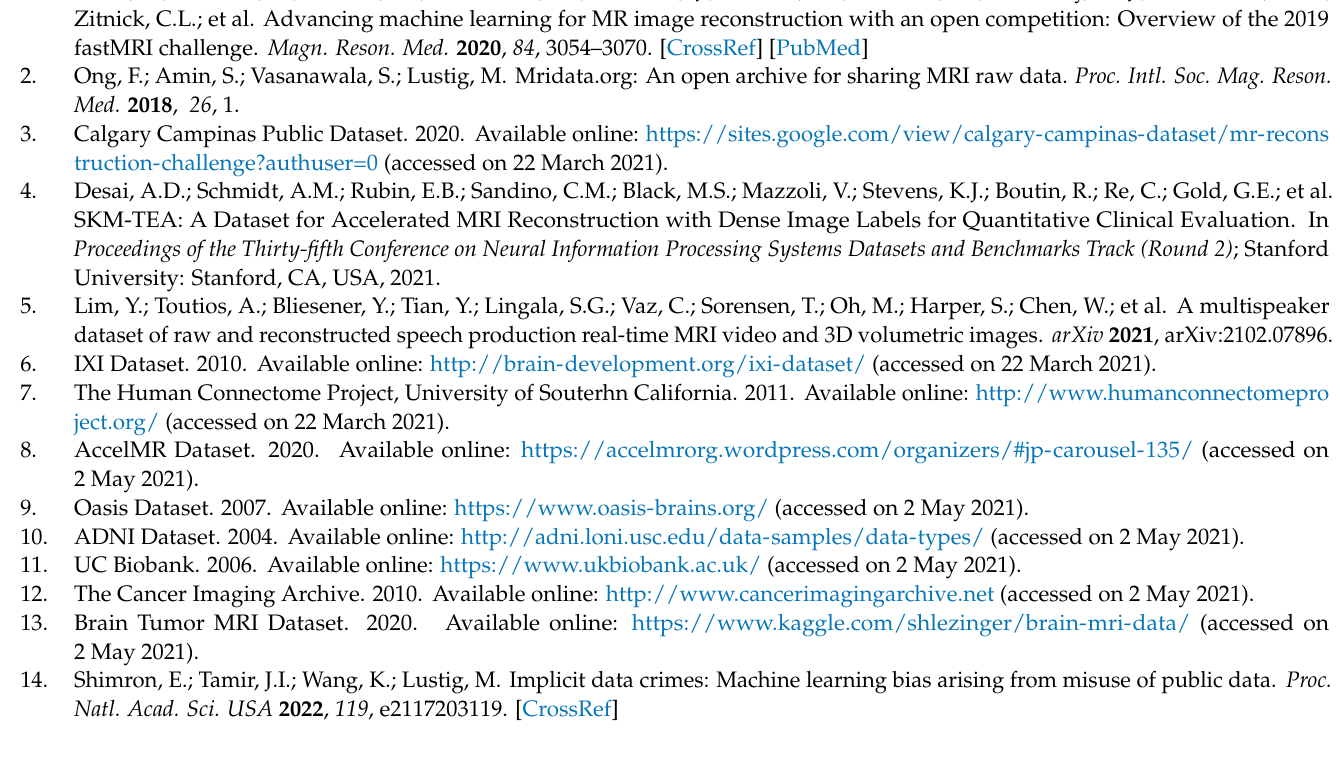
indicate the best performing type of phase (not including ground truth); Table S2: PSNR values for VarNet trained on different types of phase at various acceleration factors for the 20-coil dataset. Bold values indicate the best performing type of phase (not including ground truth); Table S3: NMSE values for VarNet trained on different types of phase at various acceleration factors for the 16-coil dataset. Bold values indicate the best performing type of phase (not including ground truth); Table S4: NMSE values for VarNet trained on different types of phase at various acceleration factors for the 20-coil dataset. Bold values indicate the best performing type of phase (not including ground truth); Table S5: SSIM values for VarNet trained on different types of phase at various acceleration factors for the 16-coil dataset. Bold values indicate the best performing type of phase (not including ground truth); Table S6: SSIM values for VarNet trained on different types of phase at various acceleration factors for the 20-coil dataset. Bold values indicate the best performing type of phase (not including ground